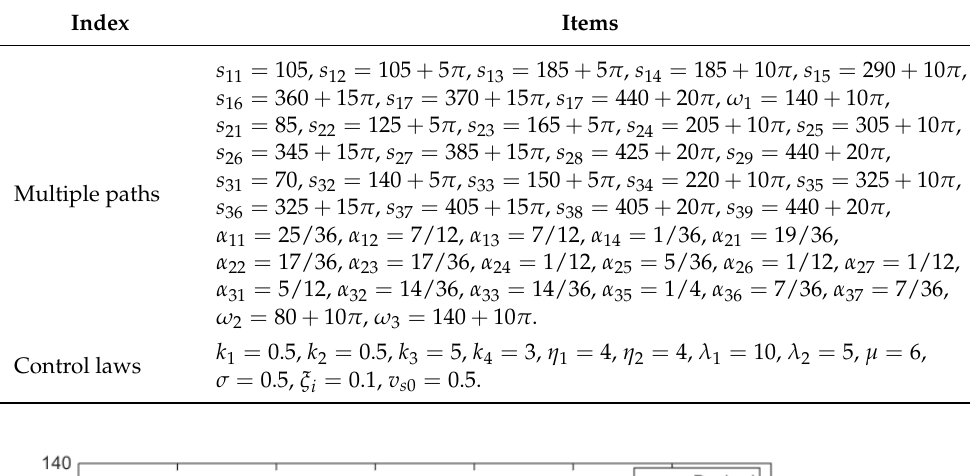
Table 2. Path parameters and control parameters.